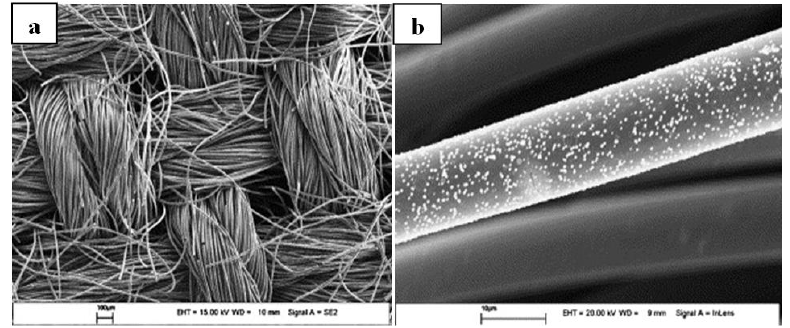
Figure 4. SEM images of the ( a ) woven activated carbon and ( b ) Pt-woven activated carbon catalyst